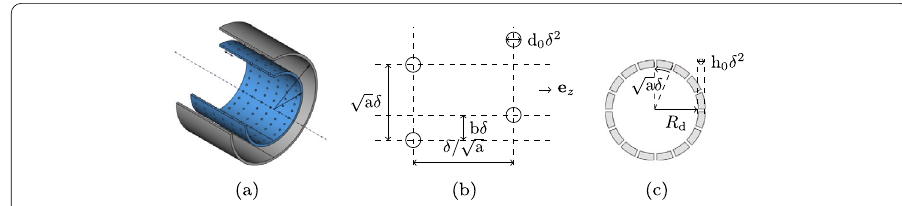
Figure 2 Split of the domain Ω into the two semi-infinite waveguides Ω ± and the multi-perforated liner section Ω c . Impedance transmission conditions on the interface Γ liner approximate the behaviour of the many perforations